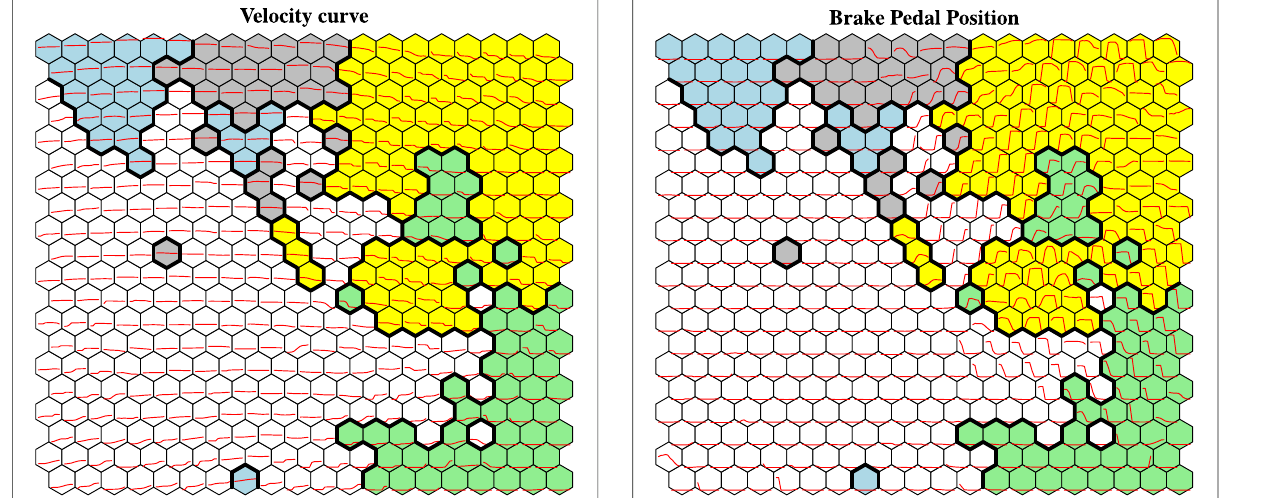
The size or radii of corresponding sectors vary with respect to the variable.